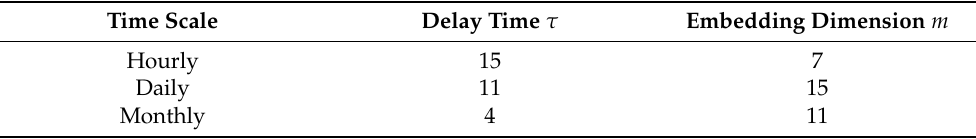
Table 3. The delay time τ and embedding dimension m of the EDH time series at different